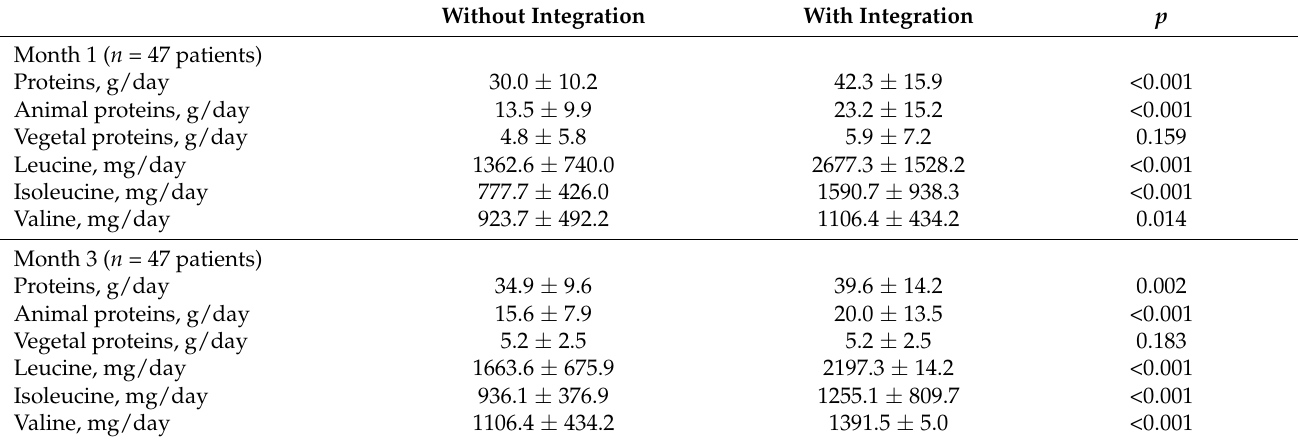
SG: sleeve gastrectomy. Paired t -test 1 month vs. 3 months. Table 3. Comparison between protein and branched-chain amino acids (BCAAs) intakes from foods and with the addition of the amounts linked to modular integration at 1 month and 3 months after